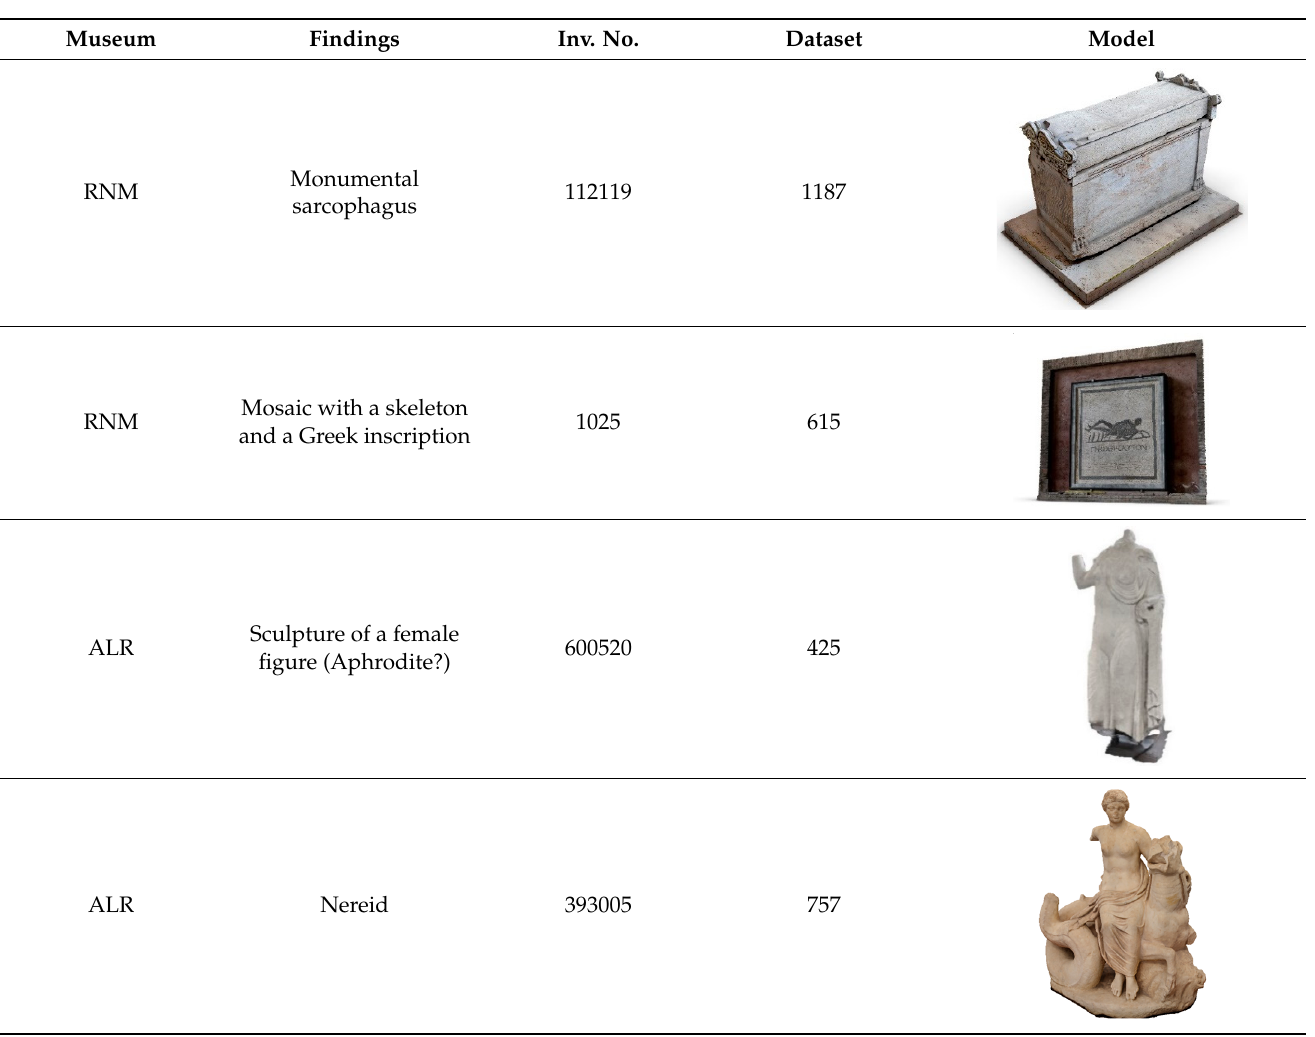
Figure 4. Internal view of Antiquarium di Villa dei Quintili. Source: MuseoItalia [78].